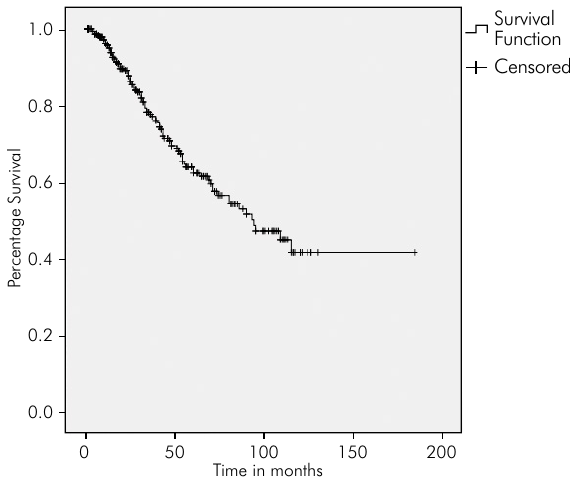
Figure. Survival function of being free of cavitated dentin carious lesion and/or restorations among patients with developmental disabilities, Belo Horizonte, Brazil, 1998 to